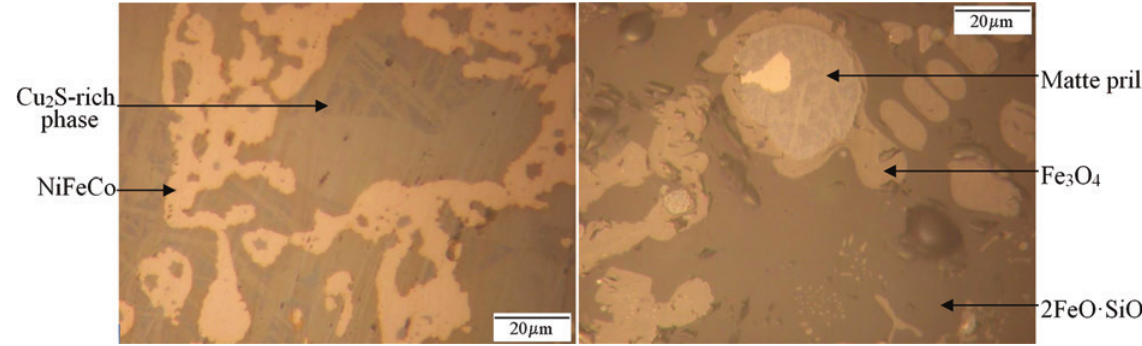
Fig. 5: Micrograph of Cu10Si tests. a) matte and b) slag.